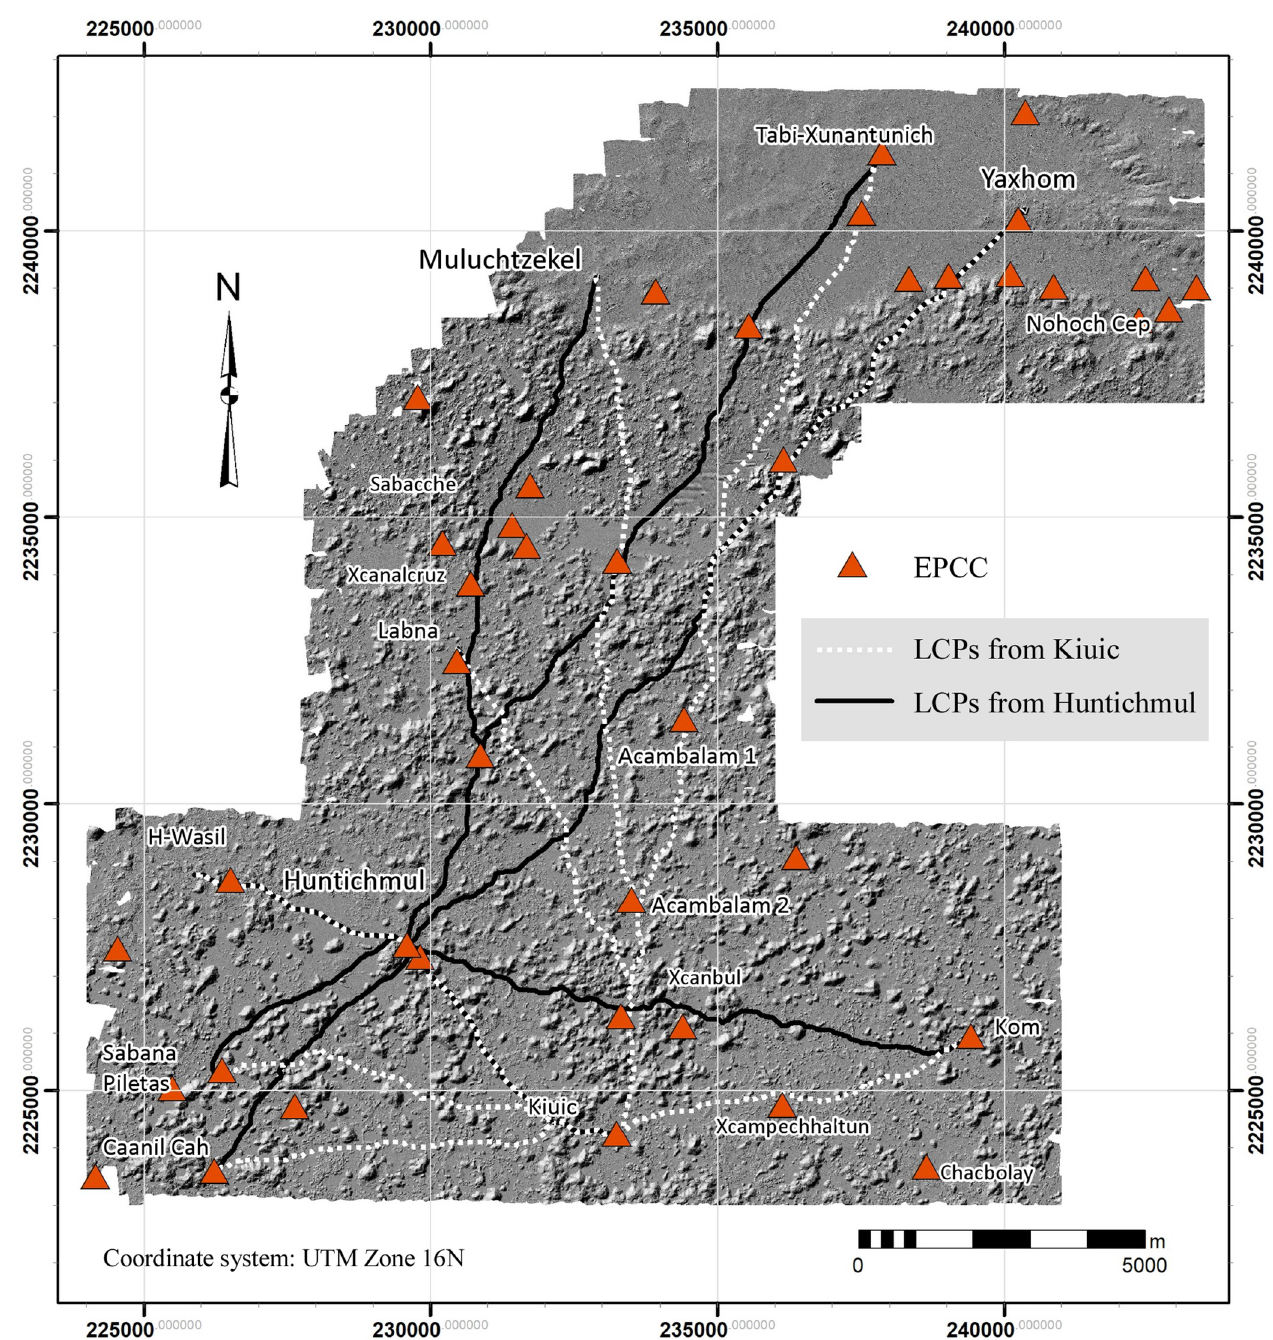
Fig 25. Spatial relation between EPCCs and